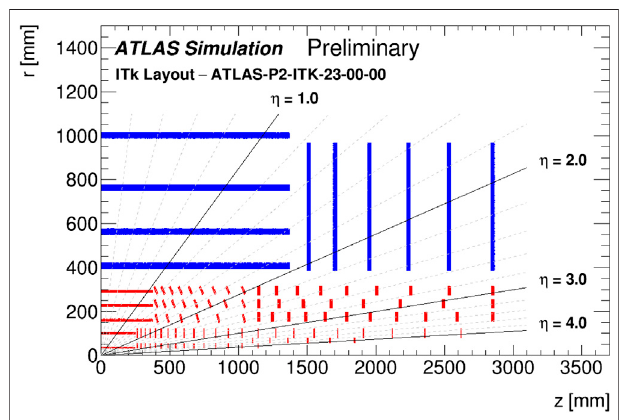
FIGURE 1 | Sketch of a quarter of the ITk detector. The Strip Detector is shown in blue, while the Pixel Detector is shown in red.